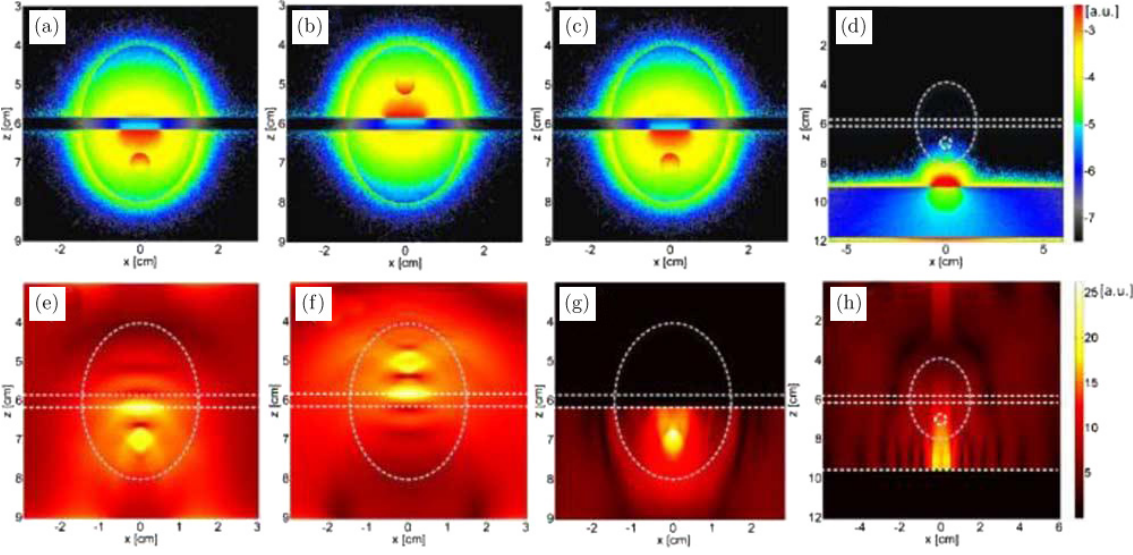
Fig. 2. Monte Carlo simulation results of PAI of tumor-imbedded prostate models at di®erent imaging con¯gurations ( (cid:2) ¼ 763 nm). (a) and (e) are the energy deposition and the PA image, respectively, using a transurethral light source and transrectal US detection. (b) and (f) are under the same con¯guration as (a) and (e) but with the tumor in the top half of the prostate. (c) and (g) are the energy deposition and PA image, respectively, using a transurethral light source and US detection. (d) and (h) are the energy deposition and PA image, respectively, using a transrectal light source and US detection. The white dash lines indicate the positions of the urethra, prostate and tumor in the PA